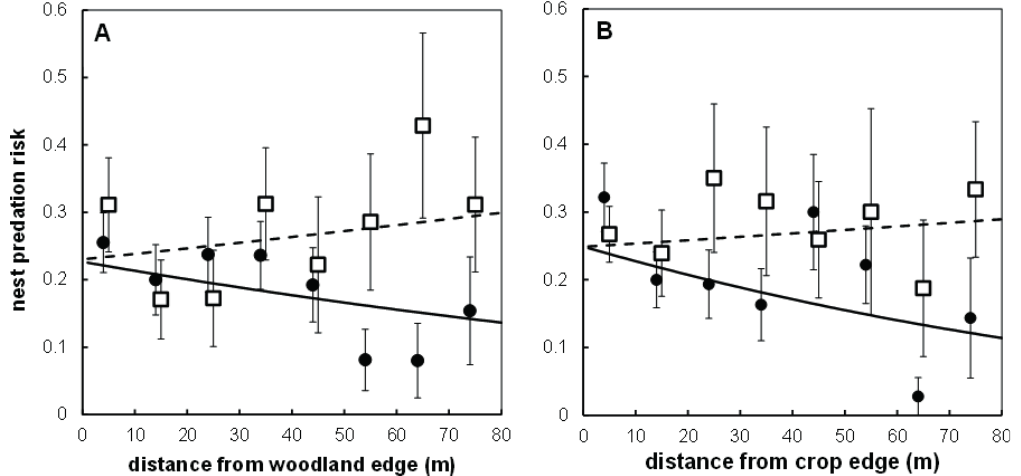
Figure 1. Nest predation risk during the breeding season (incubation + nestling stage) in short field layer (black) and tall field layer (dashed) breeding territories in relation to: (a) distance from woodland edge, and (b) distance from crop field edge. Lines show model predictions; points raw data (mean ± SE).